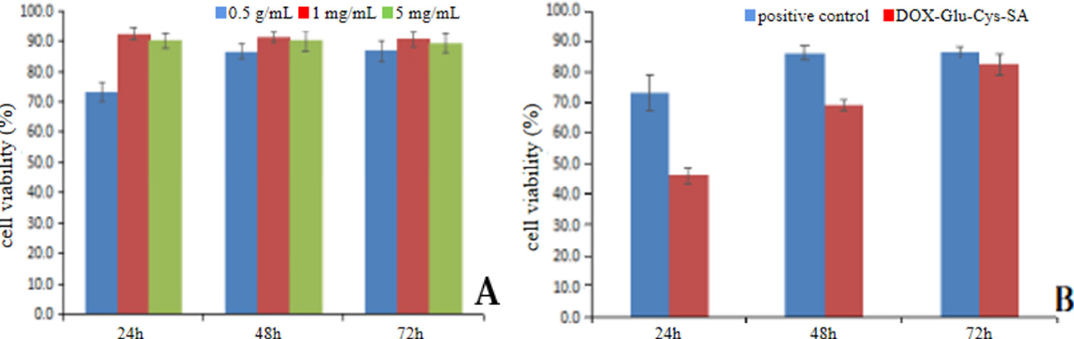
Figure 12. Cytotoxic effect of hydrogels: ( A ) the cytotoxicity of the prepared hydrogel against L929 cell; ( B ) the in vitro anti-tumor cytotoxicity of DOX-loaded hydrogel against Hep G2 cells. A